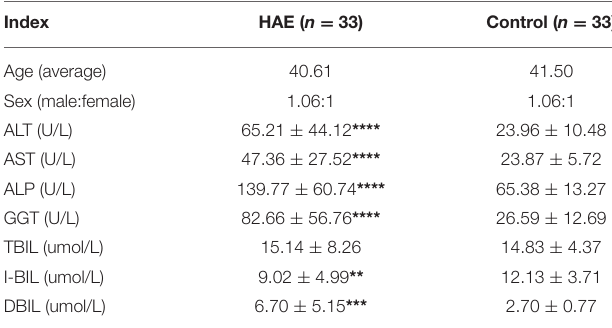
TABLE 1 | Biochemical parameters in Hepatic AE group and Healthy control group (Mean ±